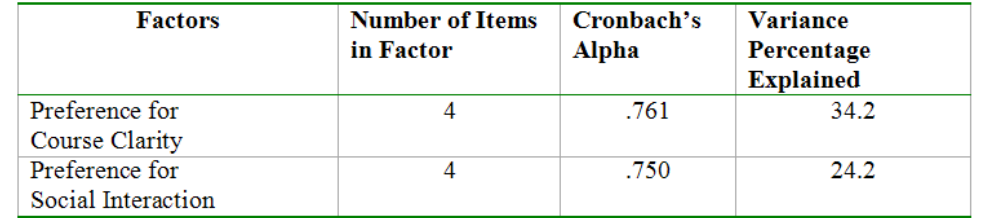
Table 3. Factor reliability of the General Learning Preferences